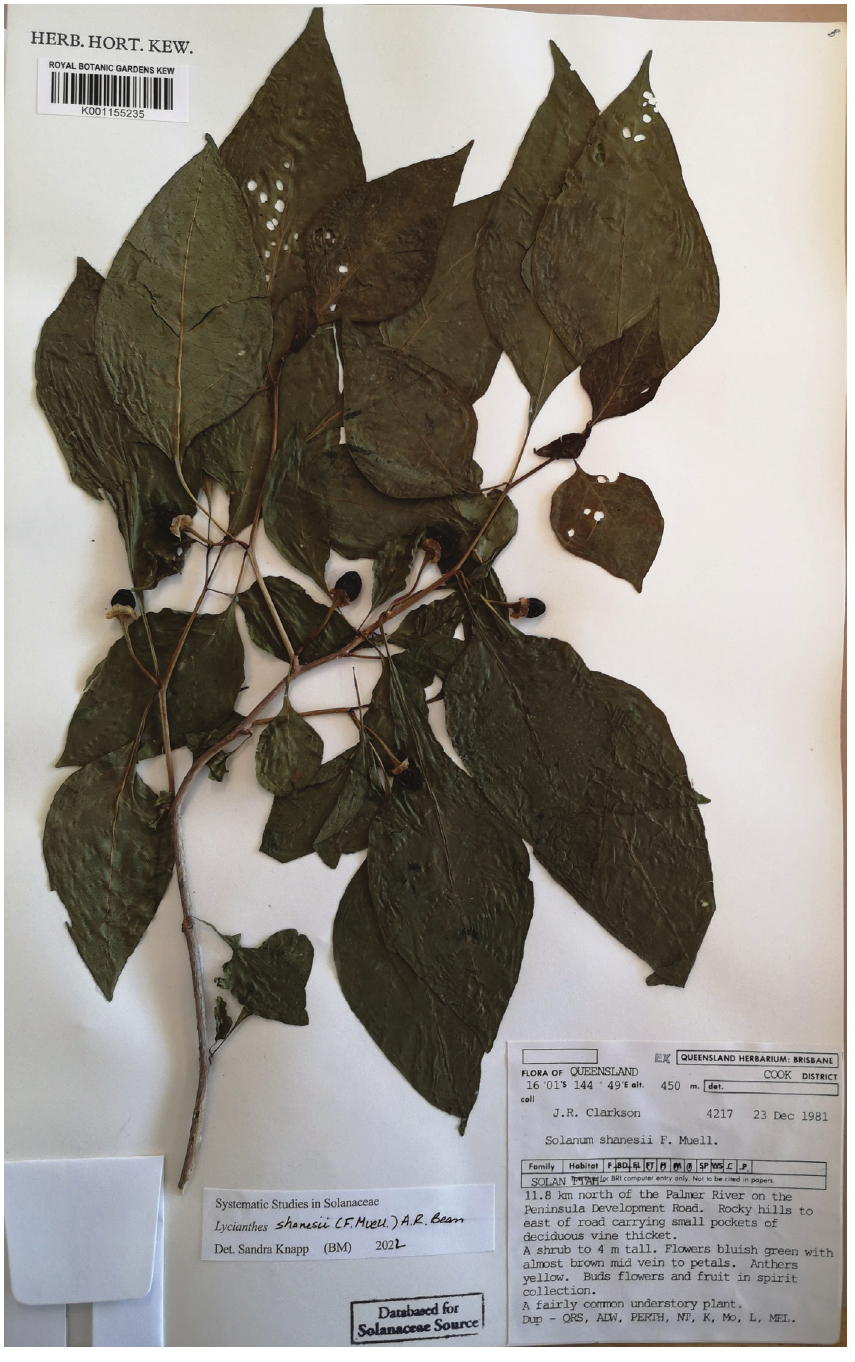
Figure 49. Lycianthes shanesii herbarium specimen. Australia. Queensland: Clarkson 4217 (K001155235). Courtesy of the Trustees of the Royal Botanic Garden, Kew, reproduced with